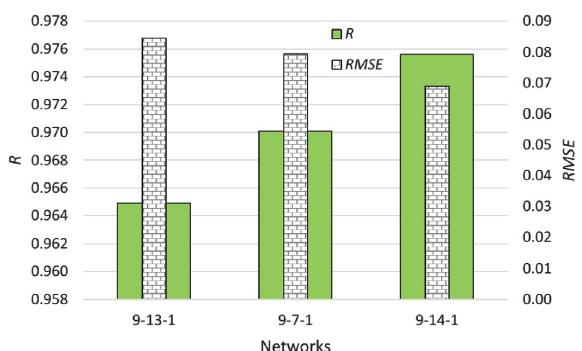
Figure 3. Comparisons of R and RMSE values of the established